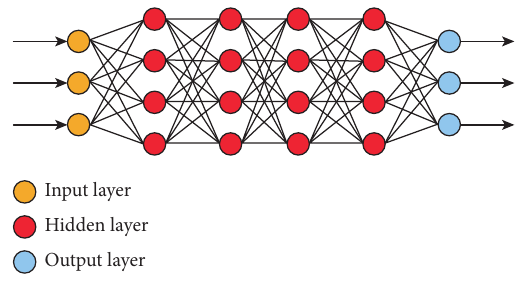
Figure 4: Deep artificial neural network (DANN) (adopted from [56]).